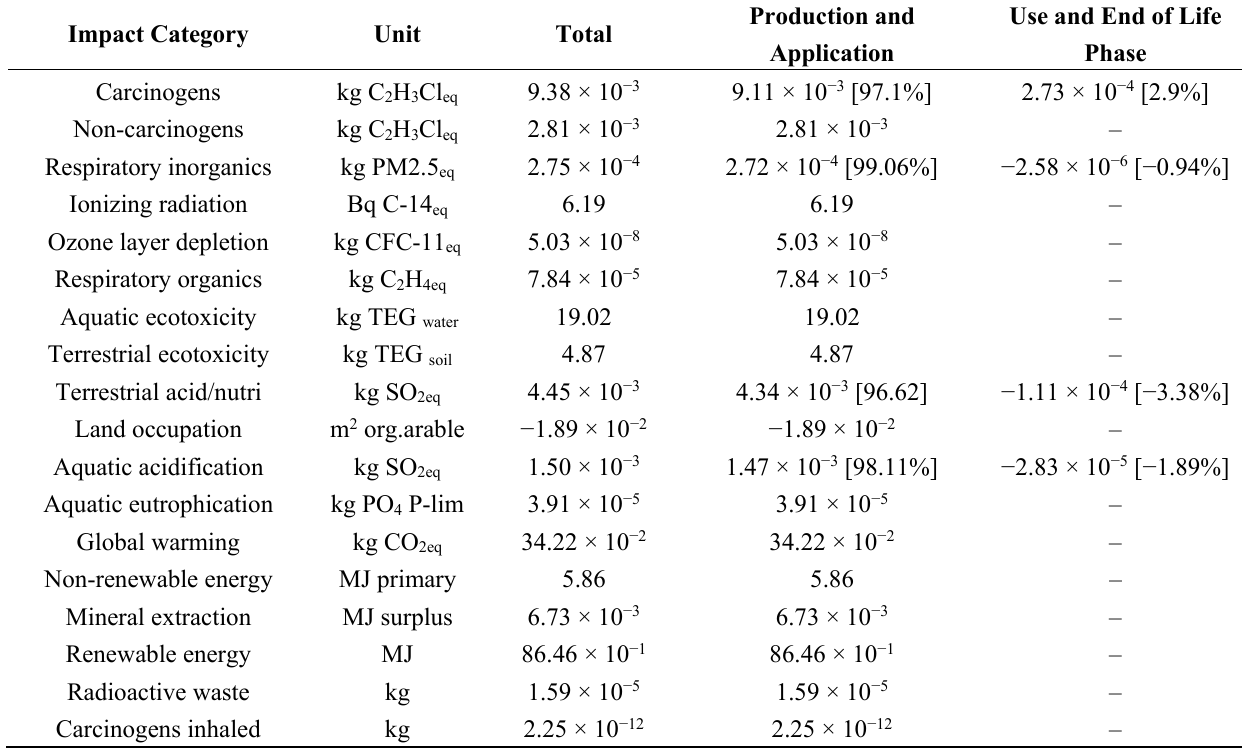
Table 2. Characterized life cycle impact assessment (LCIA) results of the entire life cycle of 1 m 2 of nano-TiO 2 coating on